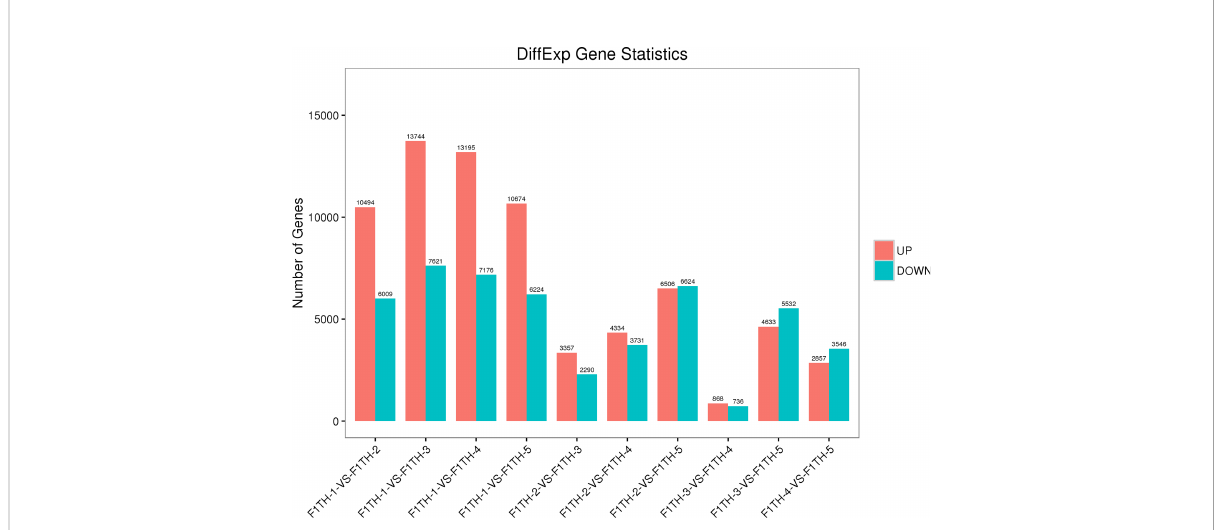
FIGURE 4 Numbers of differentially expressed genes among groups. F1TH-1, leaf; F1TH-2, bud stage; F1TH-3, in fl orescence at the color-development stage; F1TH-4, in fl orescence at the fl owering stage; F1TH-5, in fl orescence at the full-bloom